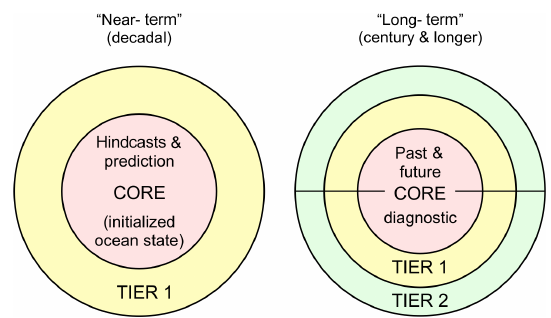
Figure 2. Schematic of focus areas of CMIP5 divided into prior- itized tiers of experiments (from Taylor et al., 2009). The DCPP structure is similar but consists of three focus areas (Hindcasts, Forecasts, Mechanisms), each of which is tiered as summarized in Table 1 and in the appendices as well as on the DCPP